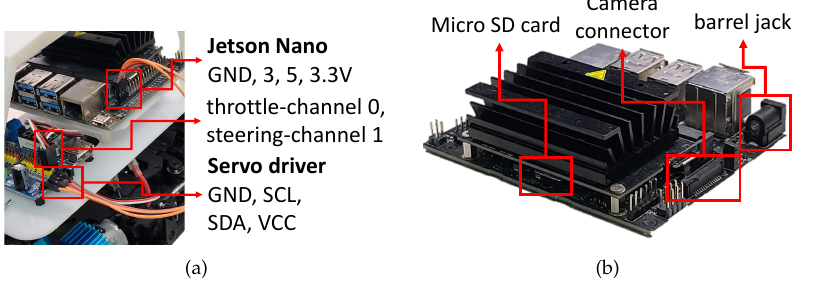
Figure 9. ( a ) DonkeyCar servo driver connection, ( b ) Jetson Nano.